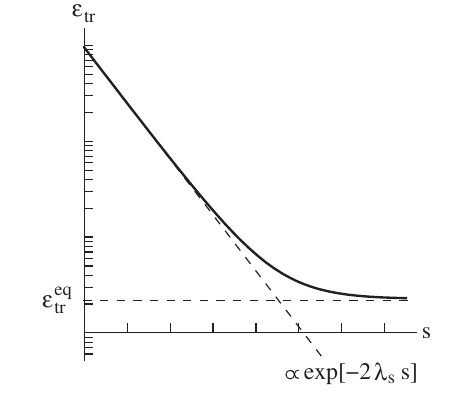
FIG. 12. Behavior of the transverse emittance in logarithmic scale.